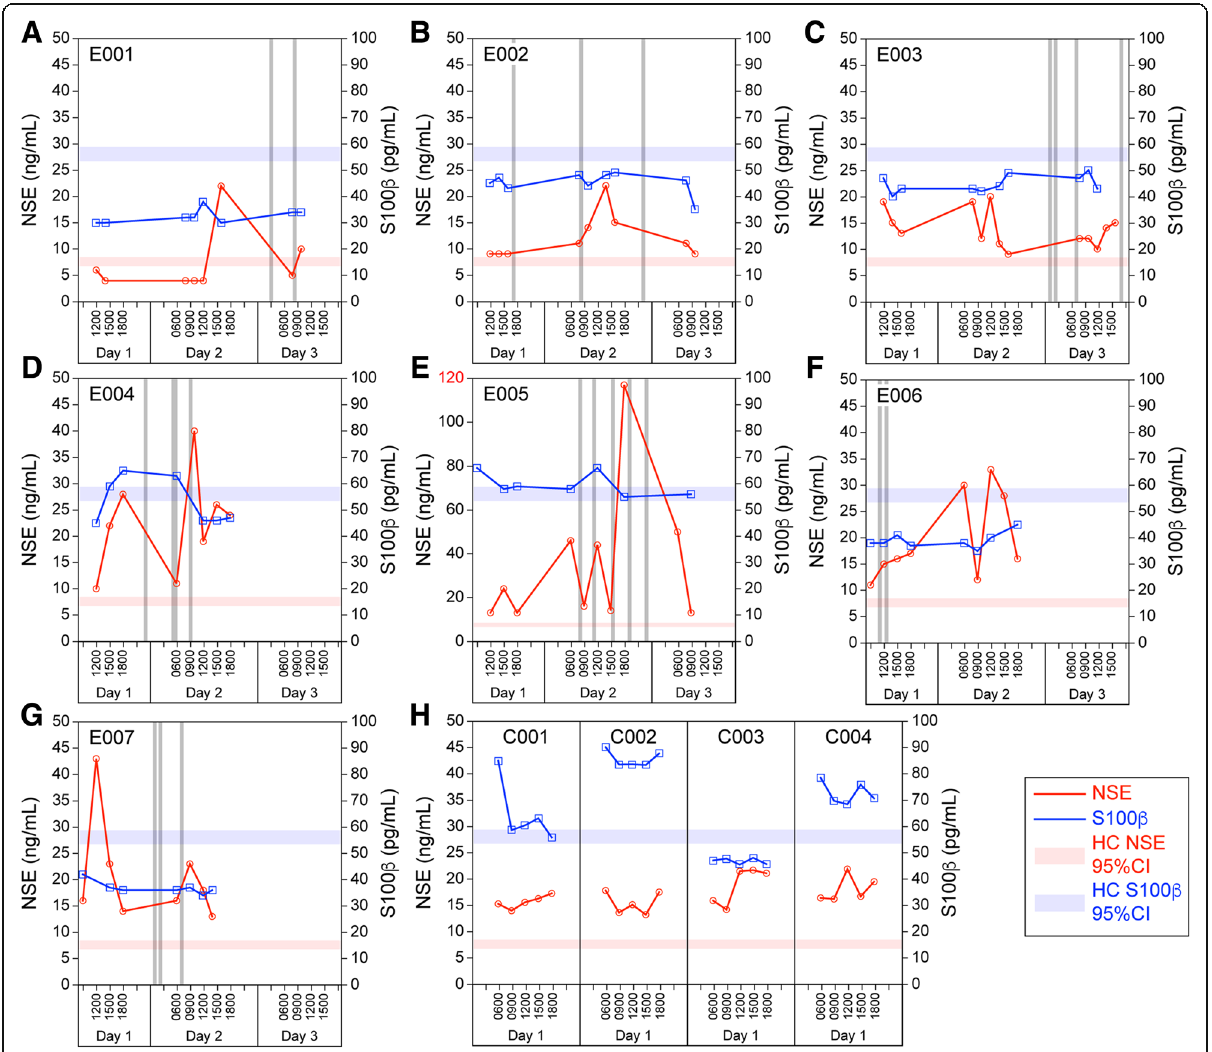
Fig. 2 “ Spikes ” in serum NSE levels are observed in epilepsy patients but not in healthy controls or in S100 β levels. Serially drawn blood samples from epilepsy patients (E001-E007, panels a - g ) and healthy controls (C001-C004, panel h ) were used to establish individual patterns of NSE (red lines) and S100 β (blue lines) in serum through time. Sampling times were restricted to 0600, 0900, 1200, 1500, and 1800 h; for EMU patients the draws continued throughout the duration of EEG monitoring. All panels are scaled to 50 ng/mL NSE (left axis) and 100 pg/mL S100 β (right axis), except for E005 (E; 120 ng/mL NSE). The horizontal light red bars in all panels represent mean ± 95% CI for NSE in single-draw healthy controls (HC); the horizontal light blue bars in all panels represent mean ± 95% CI for S100 β in single-draw healthy controls (HC). Vertical gray